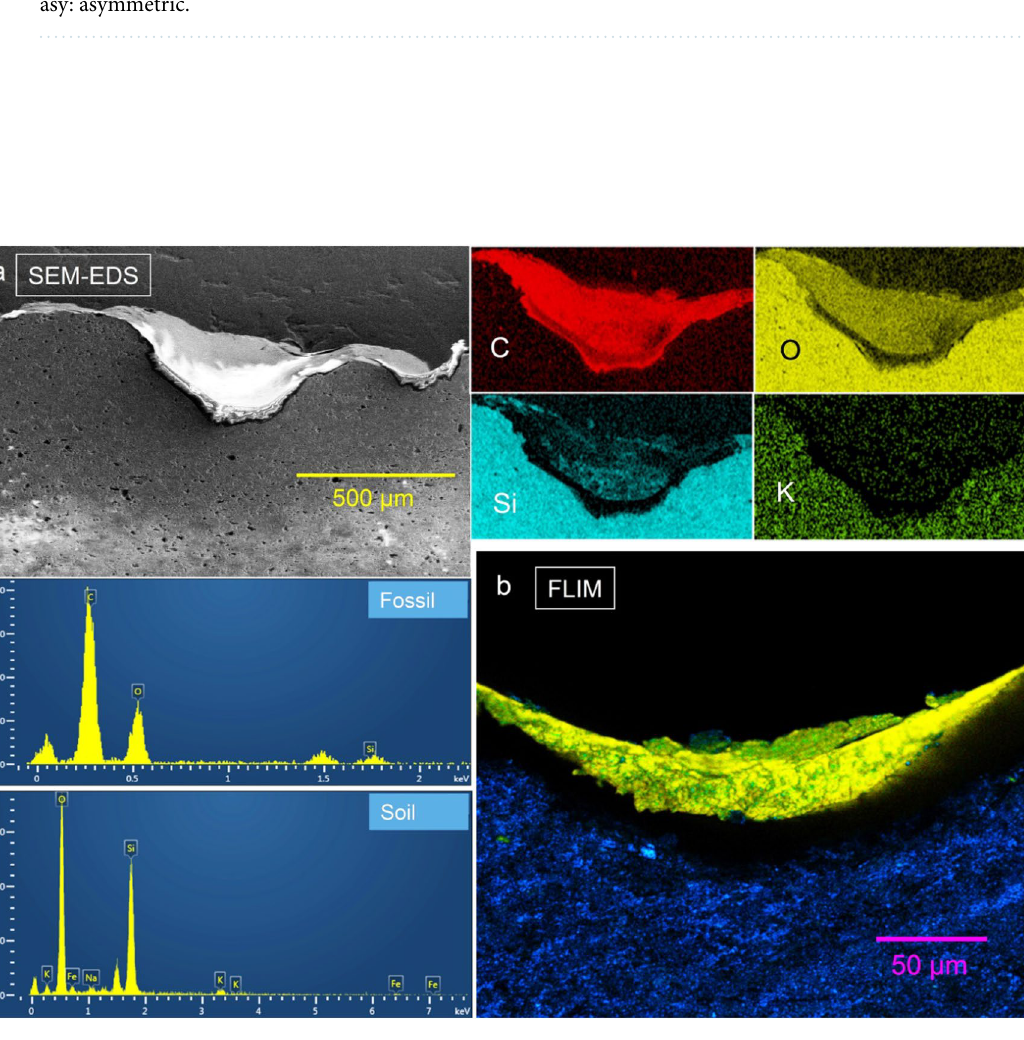
Figure 3. Confirmation of carbon and short-lived biofluorescence in fish fossil. ( a ) SEM–EDS analysis of the fish fossil cross-section showing that the fossil contains considerable quantities of carbon in comparison to the rock matrix. The rock matrix is rich in silica and has more oxygen than the fish. ( b ) FLIM image of the fossil cross-section showing strong bio-fluorescence in the fish (shown as false-coloured green-yellow region) with a lifetime of 2.7